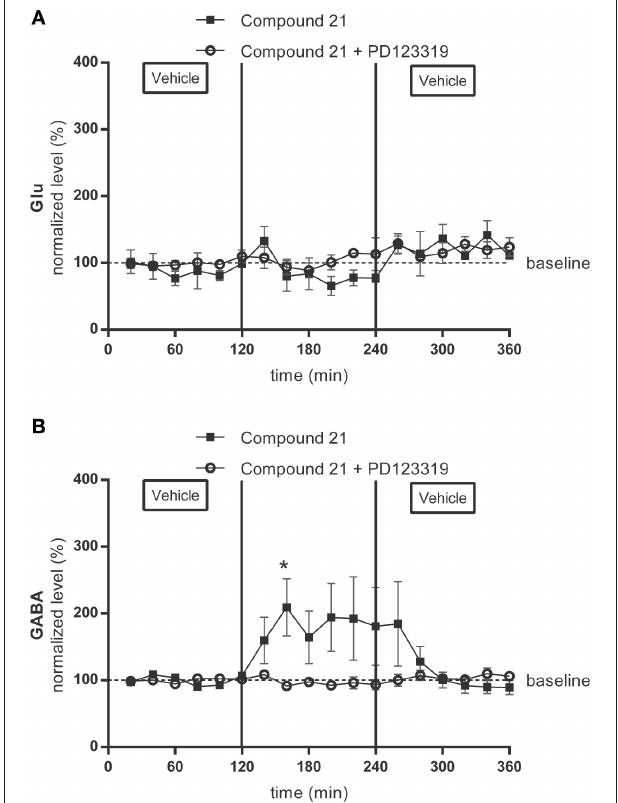
FIGURE 1 | Microdialysis experiment: effect of AT2R stimulation and infusion of the AT2R agonist C21 alone (0.05 µ g/ µ l/h) on the extracellular glutamate (Glu) (A) ( n = 4) and GABA (B) ( n = 6) concentrations and of co-infusion of C21 with the AT2R antagonist PD123319 (0.05 µ g/ µ l/h) on the extracellular glutamate (Glu) (A) ( n = 4) and GABA (B) ( n = 5) concentrations in the RVLM in normotensive freely moving Wistar rats. Dialysates were collected every 20 min. C21 and C21 + PD123319 were dissolved in modified Ringer’s solution and administered through the dialysis probe from time 120 to 240min. Data are presented as the mean percentage of the baseline values (vehicle) ± SEM. Statistical analysis for intragroup differences of the treatment is performed using one-way ANOVA for repeated measures and the Dunnett’s multiple comparison test; significant data compared to basal levels are indicated by asterisks (* p <